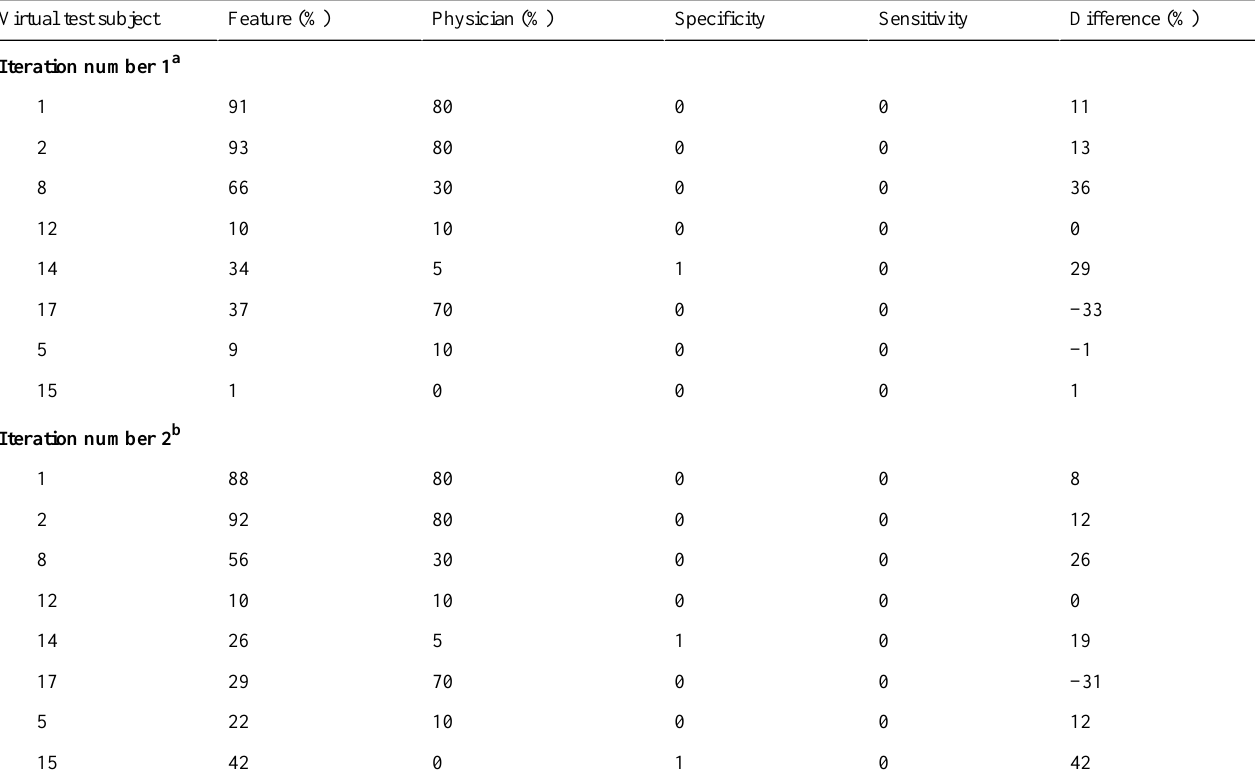
Table 5. Sensitivity, specificity, and mean difference of irregular cycle feature and physician scores by